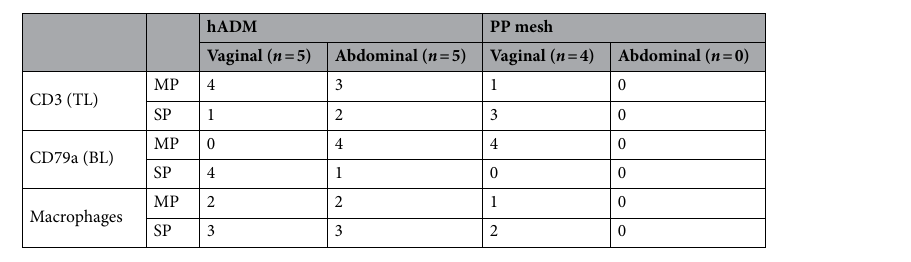
Table 3. Presence of CD3 + cells, CD79 + cells and macrophages in the hADM group and PP mesh group biopsies. Cellular presence was quantified using a 0–4 + scale and these data were grouped into 2 categories: mild (1 + , 2 +) and severe (3 + , 4 +). MP mild presence; SP severe presence. n = number of analyzed samples.